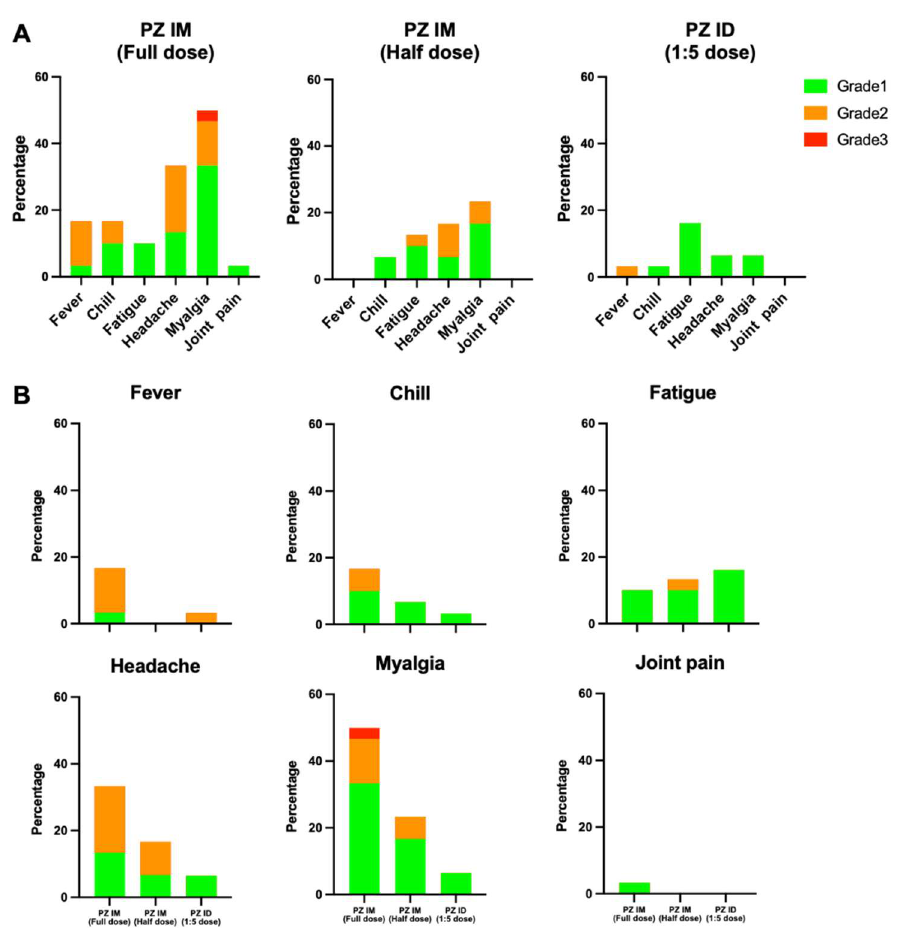
Figure 3. Solicited systemic adverse reactions at 7 days after boosting . Full dose and half dose of the mRNA vaccine were given intramuscularly after two doses of inactivated SARS-CoV-2 vaccines (PZ IM, full dose and half dose). One-fifth of the standard mRNA vaccine dose was delivered intradermally (PZ ID, 1:5 dose). ( A ) The systemic adverse events were graded, as per medical needs, and presented in percentage. The self-limited systemic reactions were grade 1 (green). The reactions requiring medications were grade 2 (orange), in need of medical attention were grade 3 (red). ( B ) Systemic reactions were presented separately to compare between the three vaccinated groups.